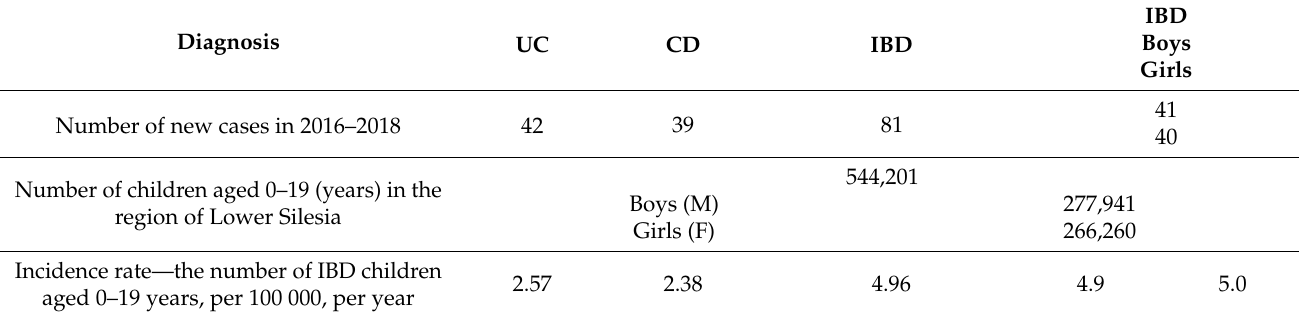
Table 4. Incidence of IBD in the paediatric population, Lower Silesia, in